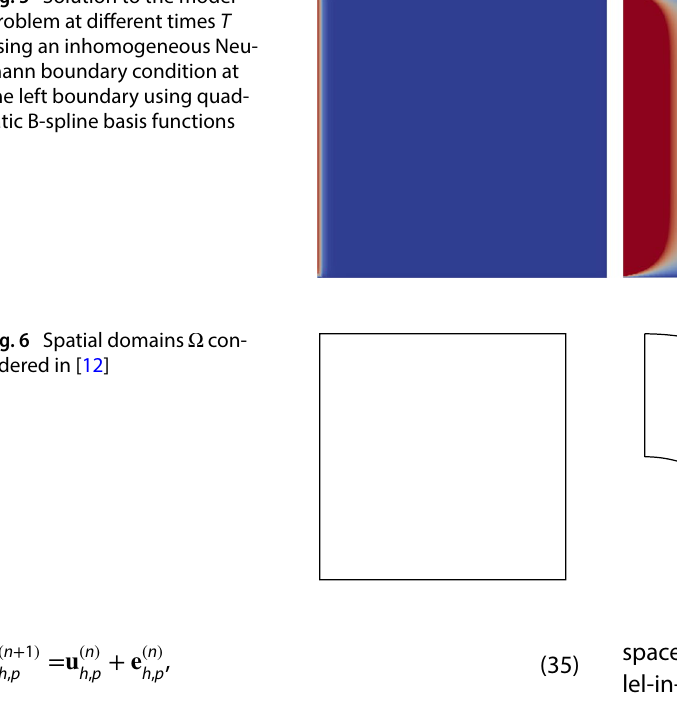
Fig. 5 Solution to the model problem at different times T using an inhomogeneous Neu- mann boundary condition at the left boundary using quad- ratic B-spline basis functions